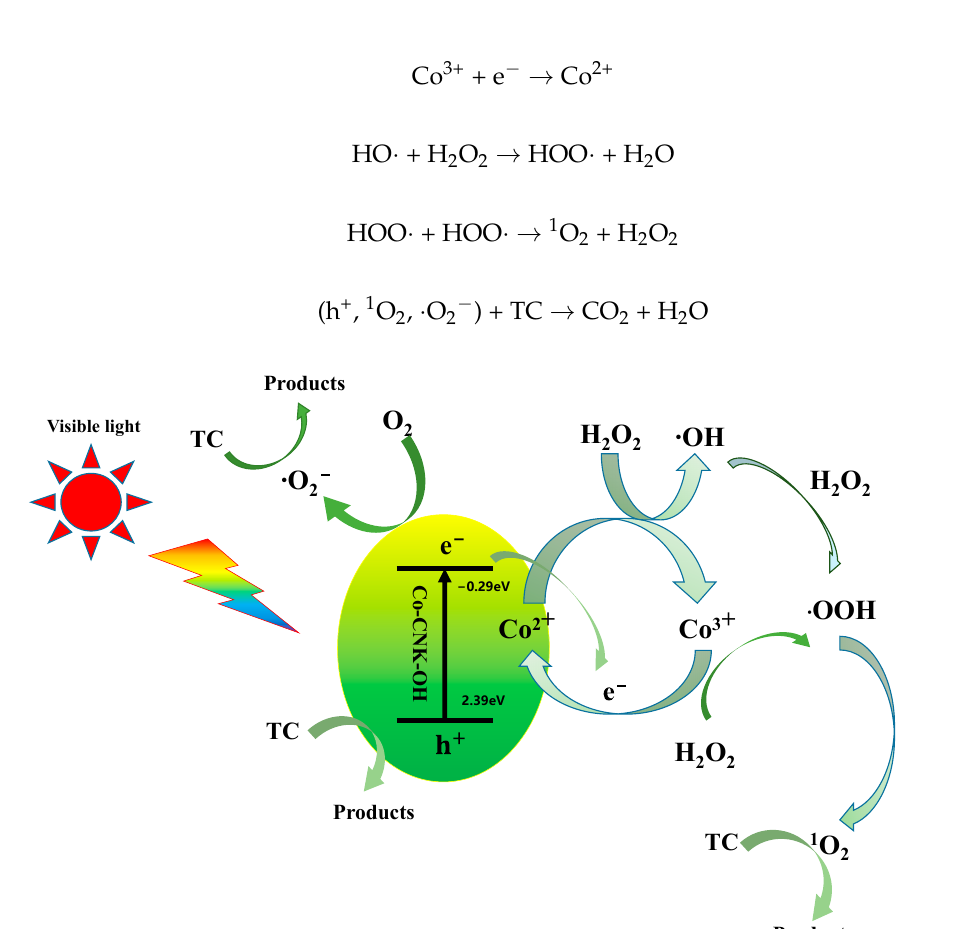
Figure 13. Possible photocatalytic mechanism of TC degradation by Co-CNK-OH in Fenton-like photocatalytic systems.